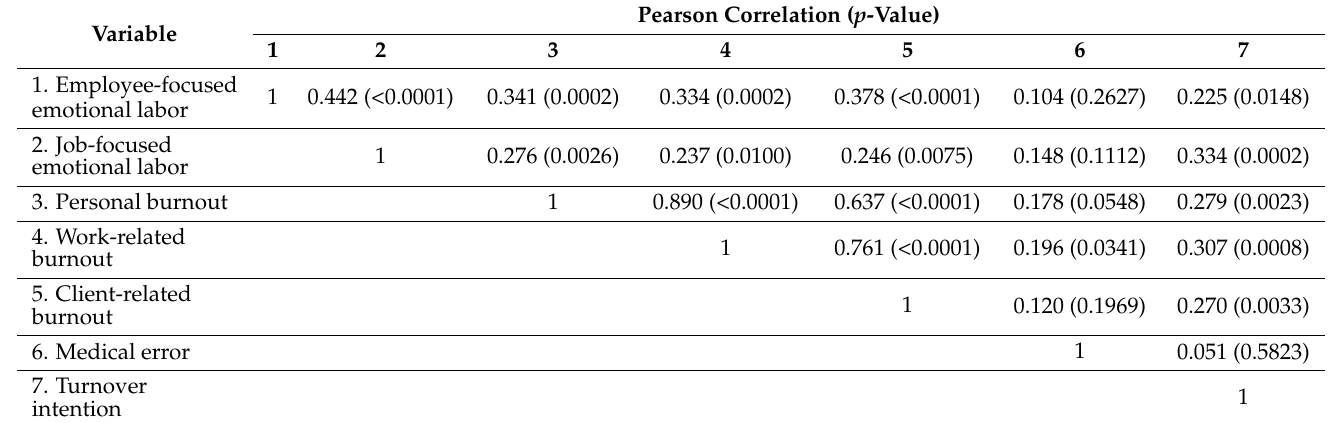
Pearson Correlation ( p